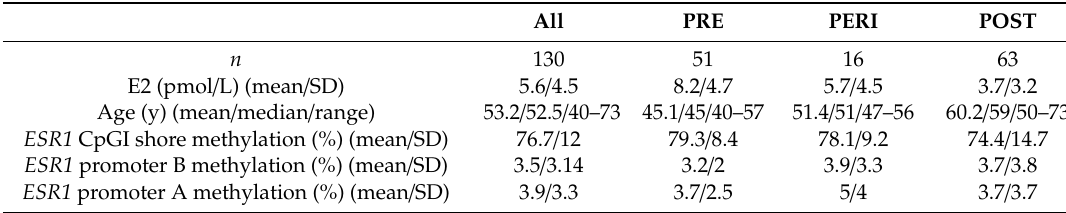
Table 1. Demographic and biological